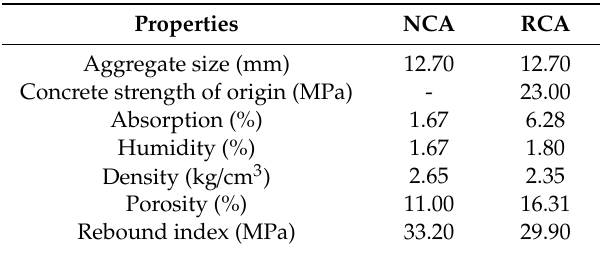
Table 1. Properties of the aggregates.